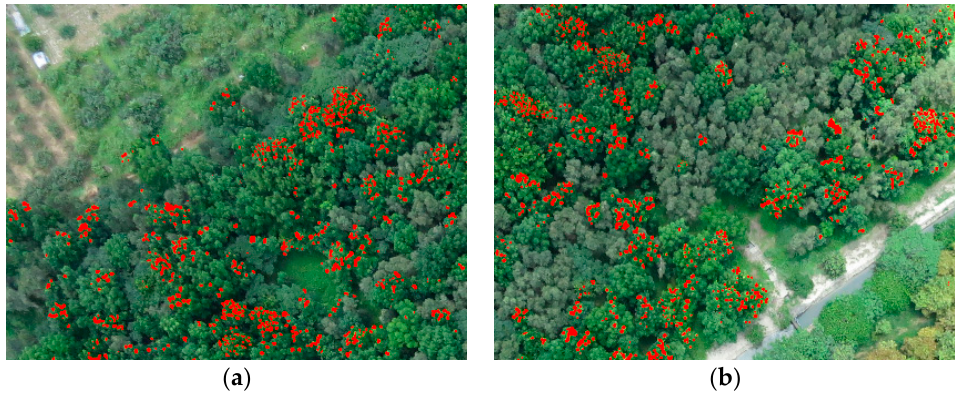
Figure 12. 1000 × 1300 Groundtruth of forest in central Taiwan: ( a ) Groundtruth of Region 1 in the original picture; ( b ) Groundtruth of Region 2 in the original picture. Table 2. Rates of Sprout and Non-Sprout in the ground truth.